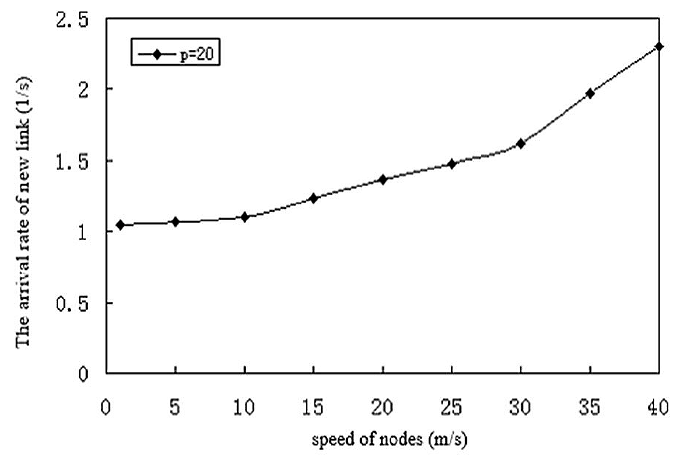
Figure 21. Effect of node density on number of hops.